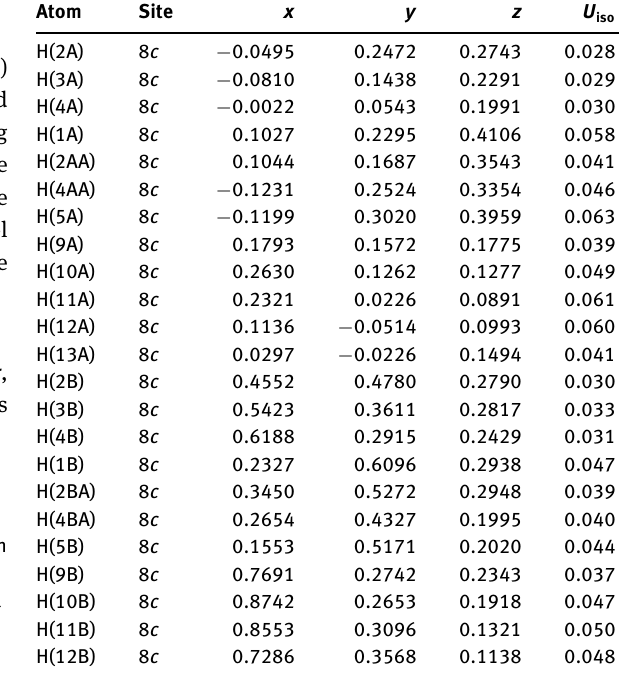
Table 2: Fractional atomic coordinates and isotropic or